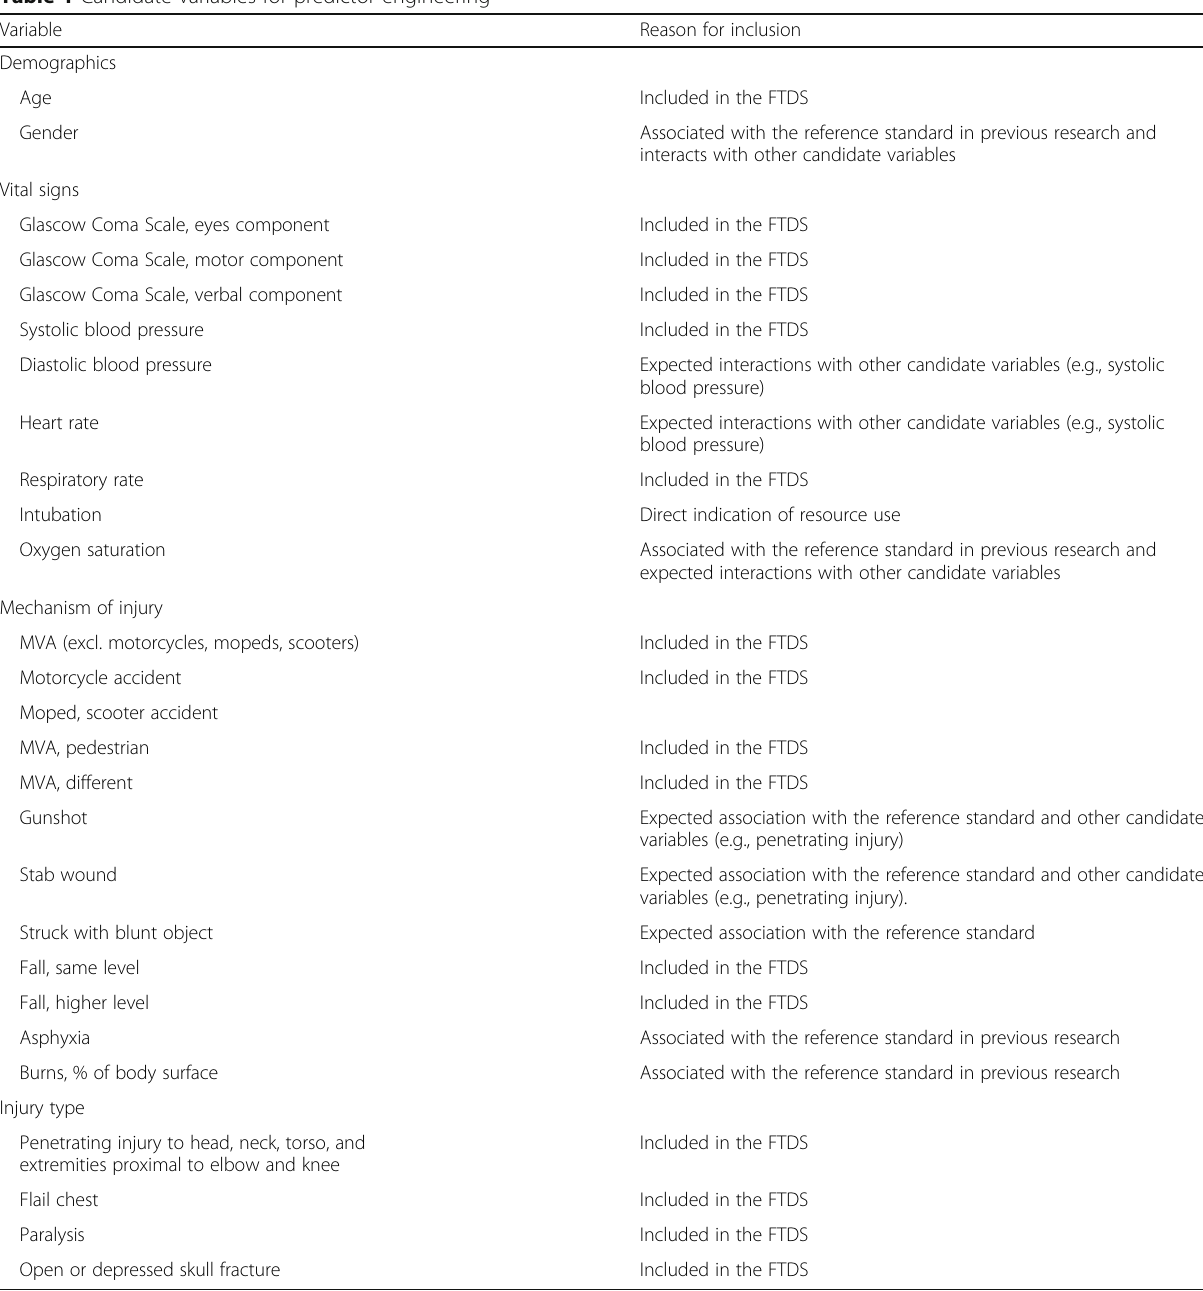
Table 1 Candidate variables for predictor engineering Variable Reason for